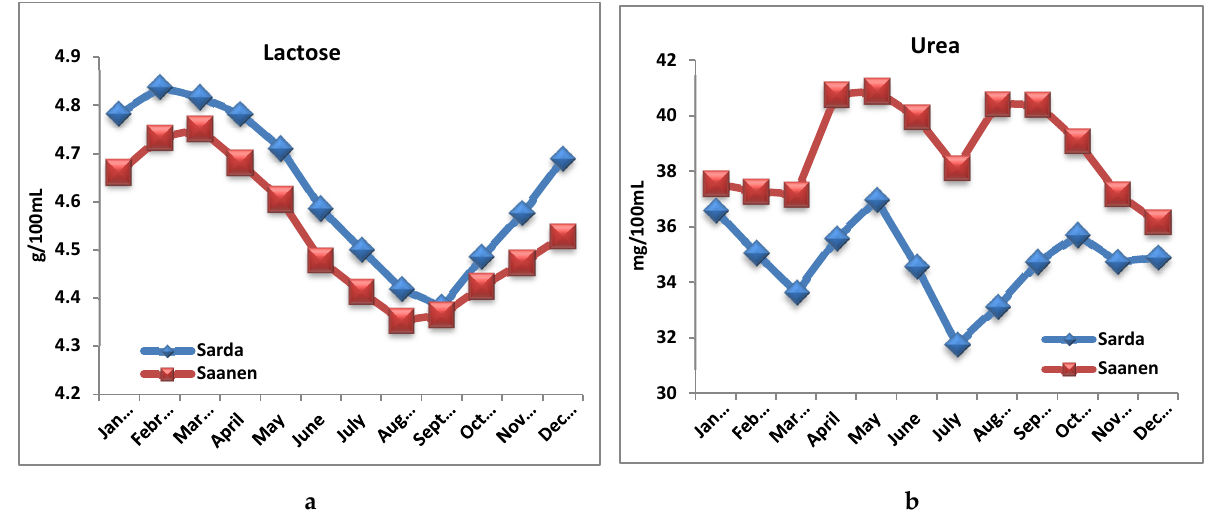
Figure 3. Monthly mean contents of: ( a ) lactose; ( b ) urea. Data are reported for the Sarda (blue line and diamonds) and Saanen (red line and squares) groups of milk samples.